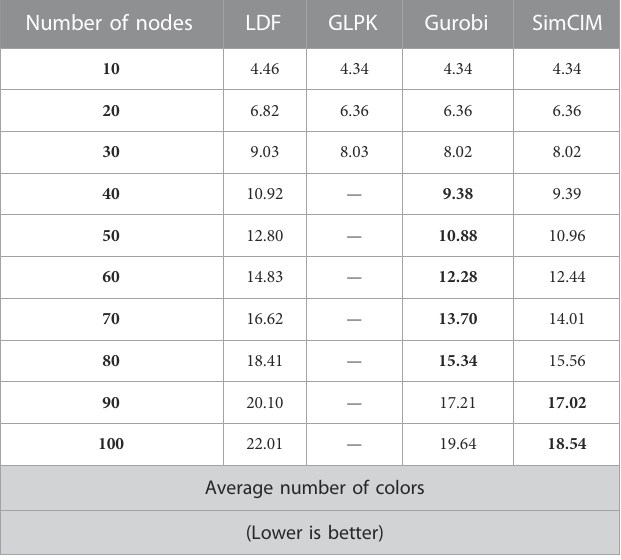
TABLE1Numericalresultsobtainedwiththelargest-degree- fi rst(LDF)heuristics, open-source mixed-integer programming solver (GLPK), Gurobi optimization software, and SimCIM quantum-inspired optimization on the number of colors averaged by the number of nodes. Number of